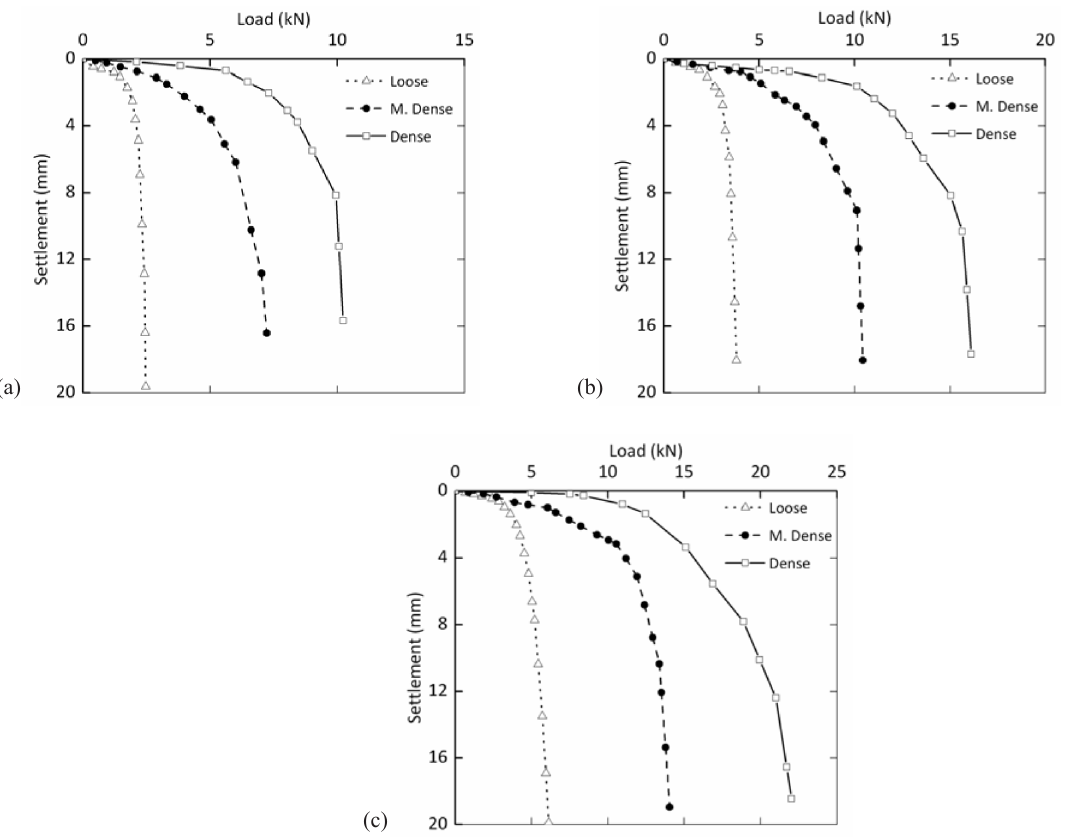
Fig. 6. Pile group tests with driven piles for S / B = 3: (a) 2-pile group; (b) 3-pile group; (c) 4-pile group